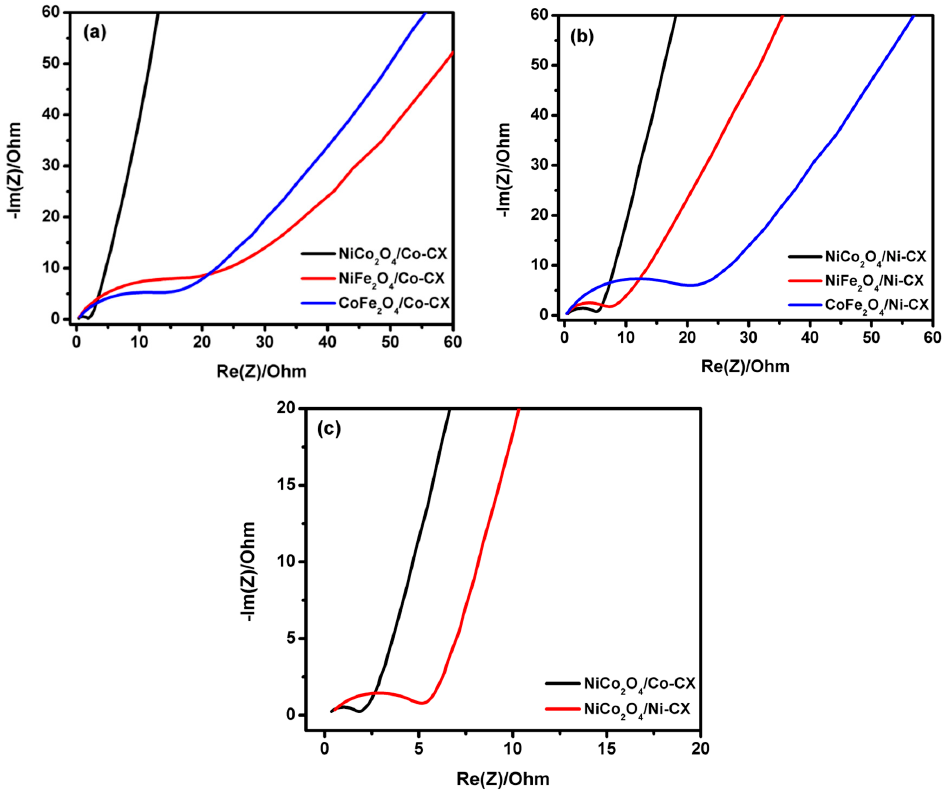
Figure 10. Nyquist plots obtained from EIS for bimetal oxides doped ( a ) Co-CX, ( b ) Ni-CX and ( c ) nickel cobaltite doped cobalt and nickel carbon xerogels.